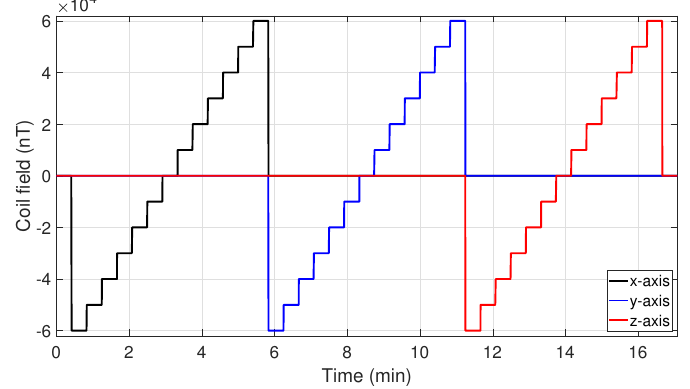
Figure 2. Applied coil fields of the LIN-60000